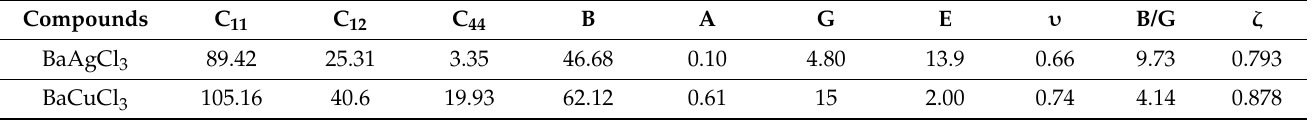
Table 2. The computed elastic parameters including the cubic elastic constants (C 11 , C 12 , and C 44 in GPa), the Bulk modulus “B” (in GPa), anisotropy factor “A”, Shear modulus “G” (in GPa), Young’s modulus “E” (in GPa), Poisons ration “ υ ” and the Pugh ratio (B/G) and the Kleinman parameter ( ζ